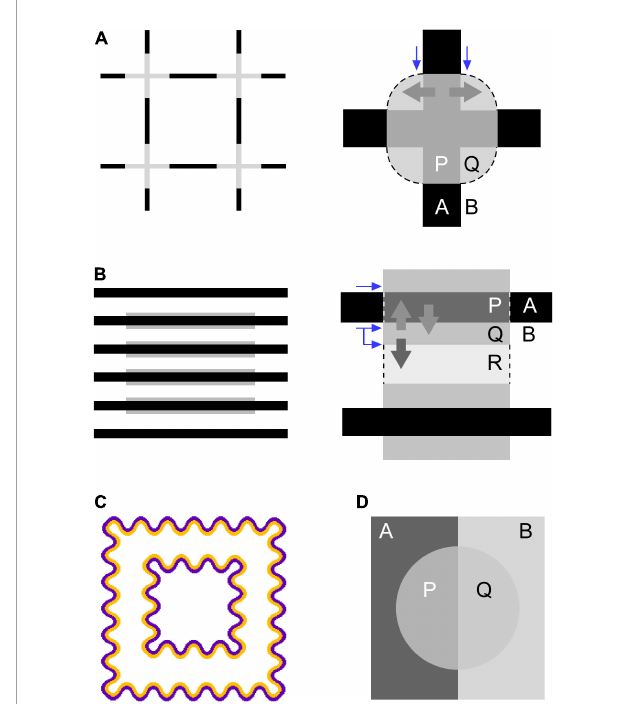
FIGURE2 Accounts for color spreading and perceptual transparency in (A) neon-color spreading and (B) flank transparency displays from the viewpoints of boundary interactions (Grossberg and Mingolla, 1985; Bressan, 1995) as well as the extended episcotister model (Metelli, 1970; Ekroll and Faul, 2002). The left figure demonstrates color spreading illusion in each configuration. The right figure schematically illustrates how color spreading and perceptual transparency are explained. (C) An example of a typical orange-purple watercolor display. (D) A four-color perceptually transparent display resulting from rotating the episcotister (Metelli, 1970). In the right figures, different letters (A, B, P, Q, and R) designate different regions in the display. Blue and thick gray arrows describe inhibitory effects on boundaries and spreading out of the region’s color, respectively. See the text for